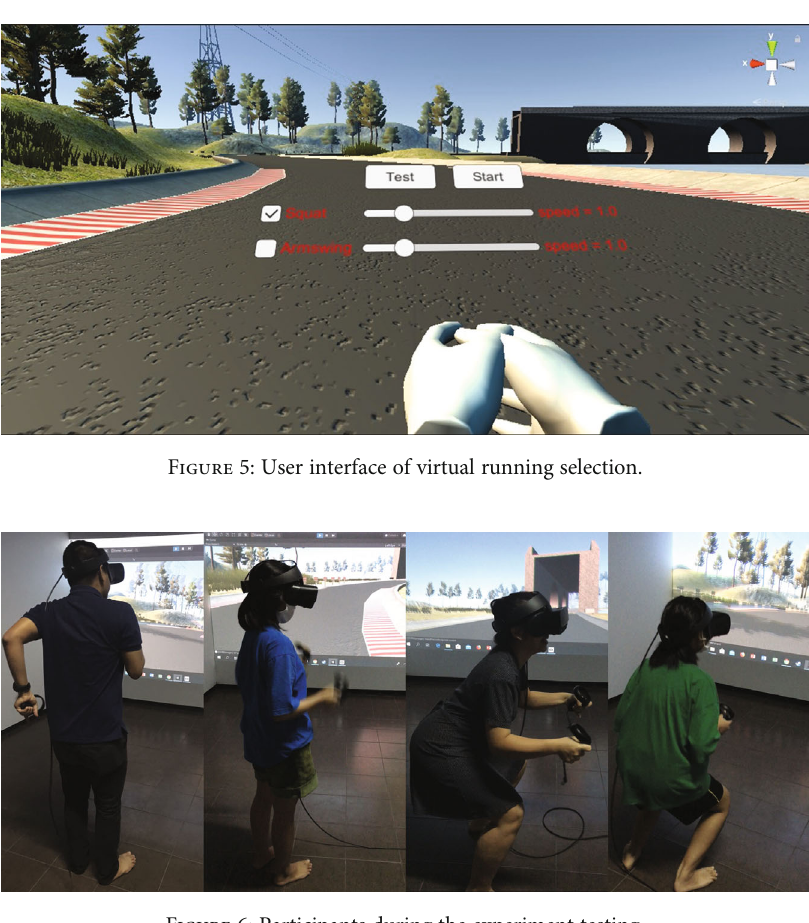
Figure 6: Participants during the experiment testing. Table 3: The results of the Wilcoxon signed-rank test for motion sickness, usability, and enjoyment ( ∗ signi fi cant p < 0 : 05 , ∗∗ highly signi fi cant p < 0 : 01